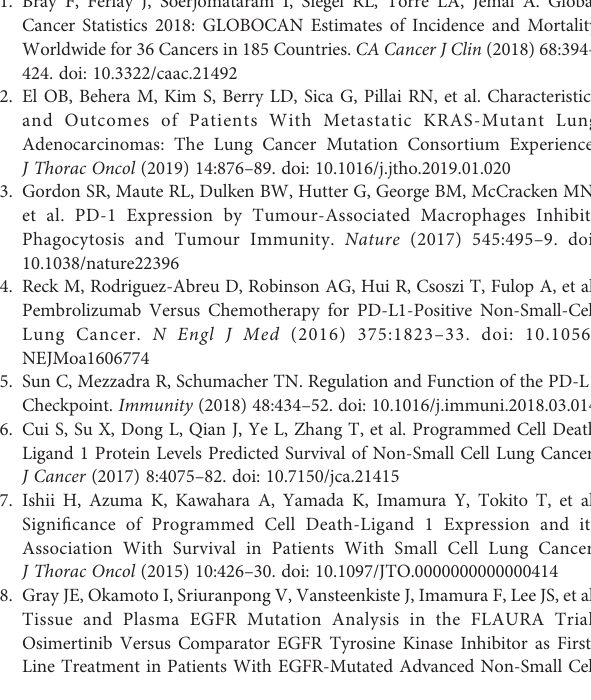
Supplementary Figure 4 | Funnel plot of progression-free survival in patients with non-small cell lung